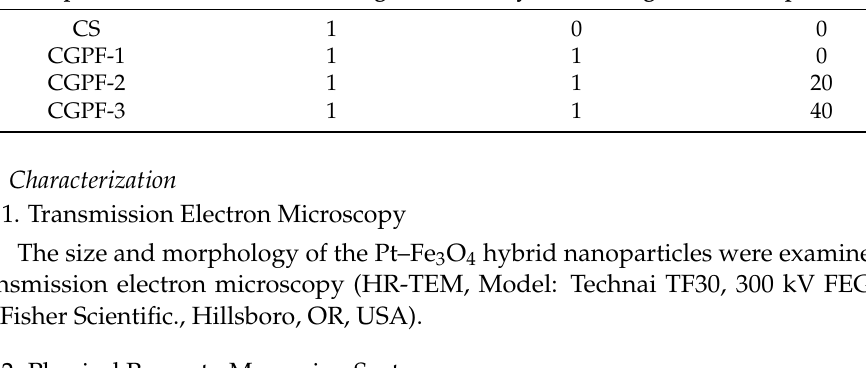
Table 1. The formulation of glycolic acid-grafted chitosan with hybrid nanoparticles . Sample Code